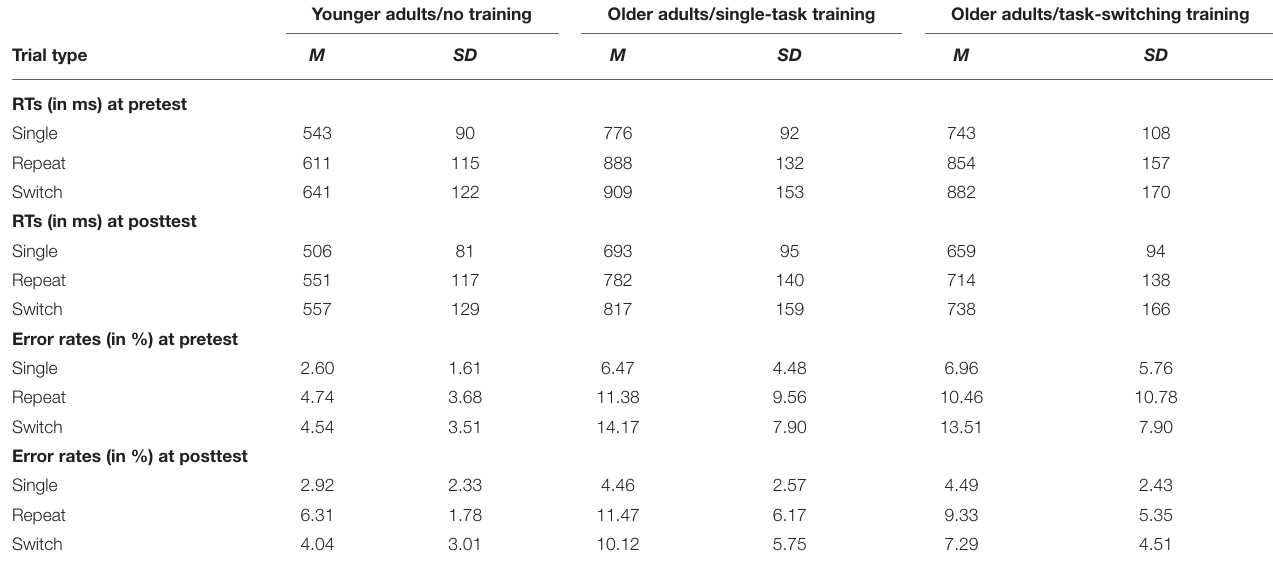
TABLE 4 | Means (M) and standard deviations (SD) for RTs (ms) and error rates (%) as a function of group and trial type separately for the pretest and